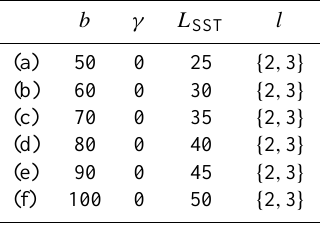
Table 3. Parameter combinations of the example for SST. b : a time length of both past and future parts, γ : a start position of the subtime series in the future part from the reference time, L SST : a window length for these subtime series, l : the number of the left singular vectors of the past part to span a